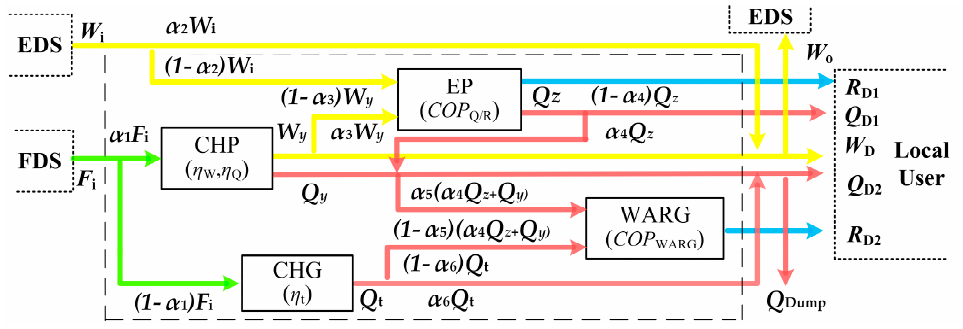
Figure 2. The diagram of a typical combined cooling, heat, and power (CCHP) plant.